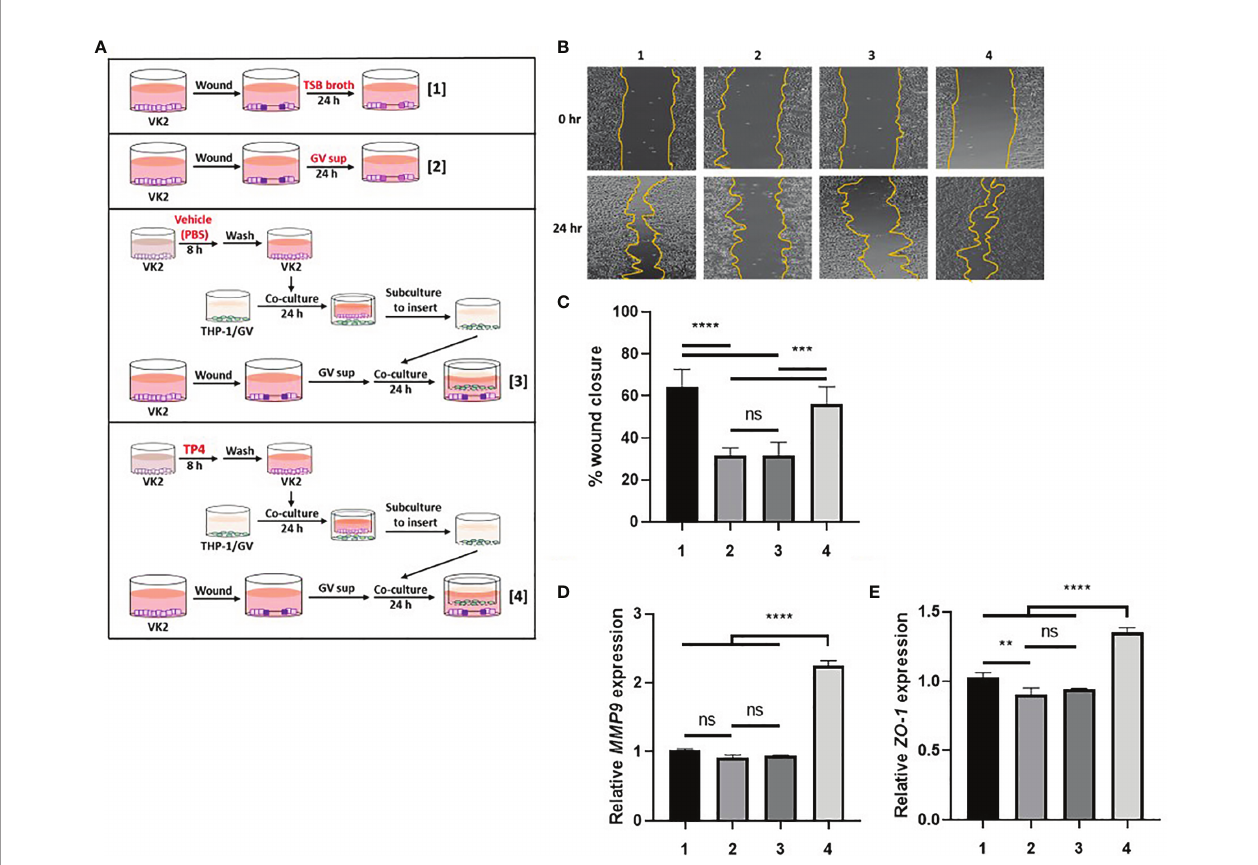
FIGURE 5 | TP4-induced M2a macrophages promote VK2 cell migration and epithelial barrier integrity. (A) Schematic description of the treatment methods. VK2 cell monolayers were scratched with a sterile pipette and then treated with [treatment 1] TSB broth or [treatment 2] 10% (v/v) GV sup. Meanwhile, GV sup-treated VK2 cells were co-cultured with THP-1/GV cells which had been incubated with [treatment 3] vehicle (PBS)- or [treatment 4] TP4 (7.82 µg/ml)-treated VK2 cells. (B) Wound-healing assays were performed at 0 and 24 h in VK2 cells. (C) Wound closure was calculated as the percent area remaining uncovered by the cells at the given timepoint. (D) MMP9 expression was measured by qRT-PCR after 24 h co-culture. (E) ZO-1 expression was measured by qRT-PCR after 48 h co-culture. Data were represented the normalized target gene amount relative to the group of treatment 1. Data are presented as mean ± SD of three independent experiments (** P < 0.01; *** P < 0.001; **** P < 0.0001; ns, not statistically signi fi